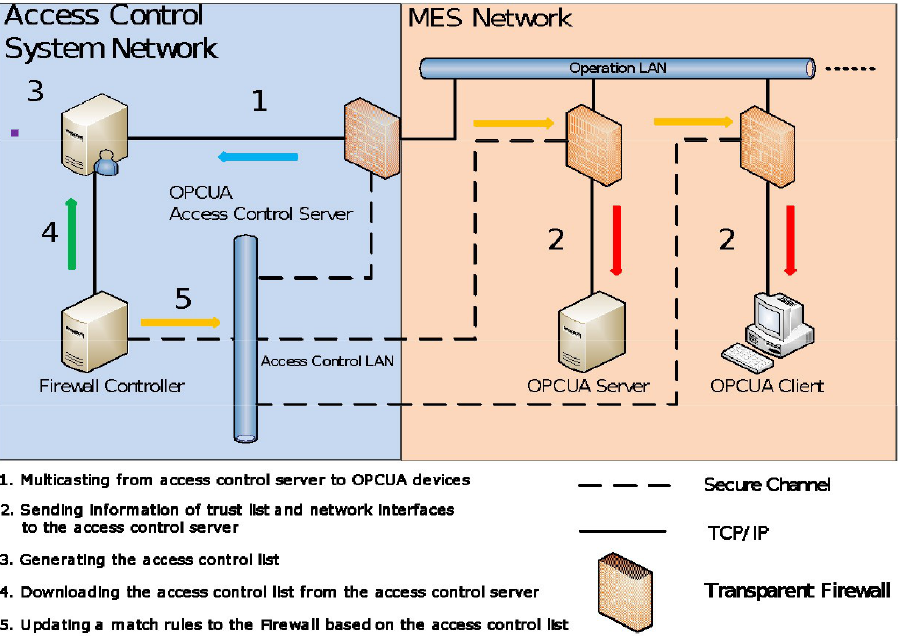
Figure 6. Structure of spatial filtering